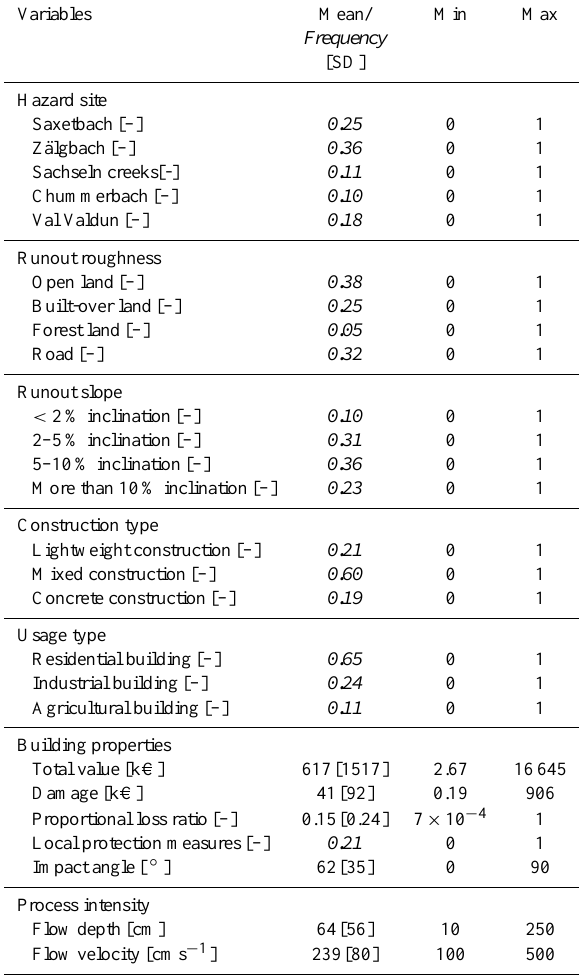
Table 1. Descriptive statistics of the compiled dataset ( N =